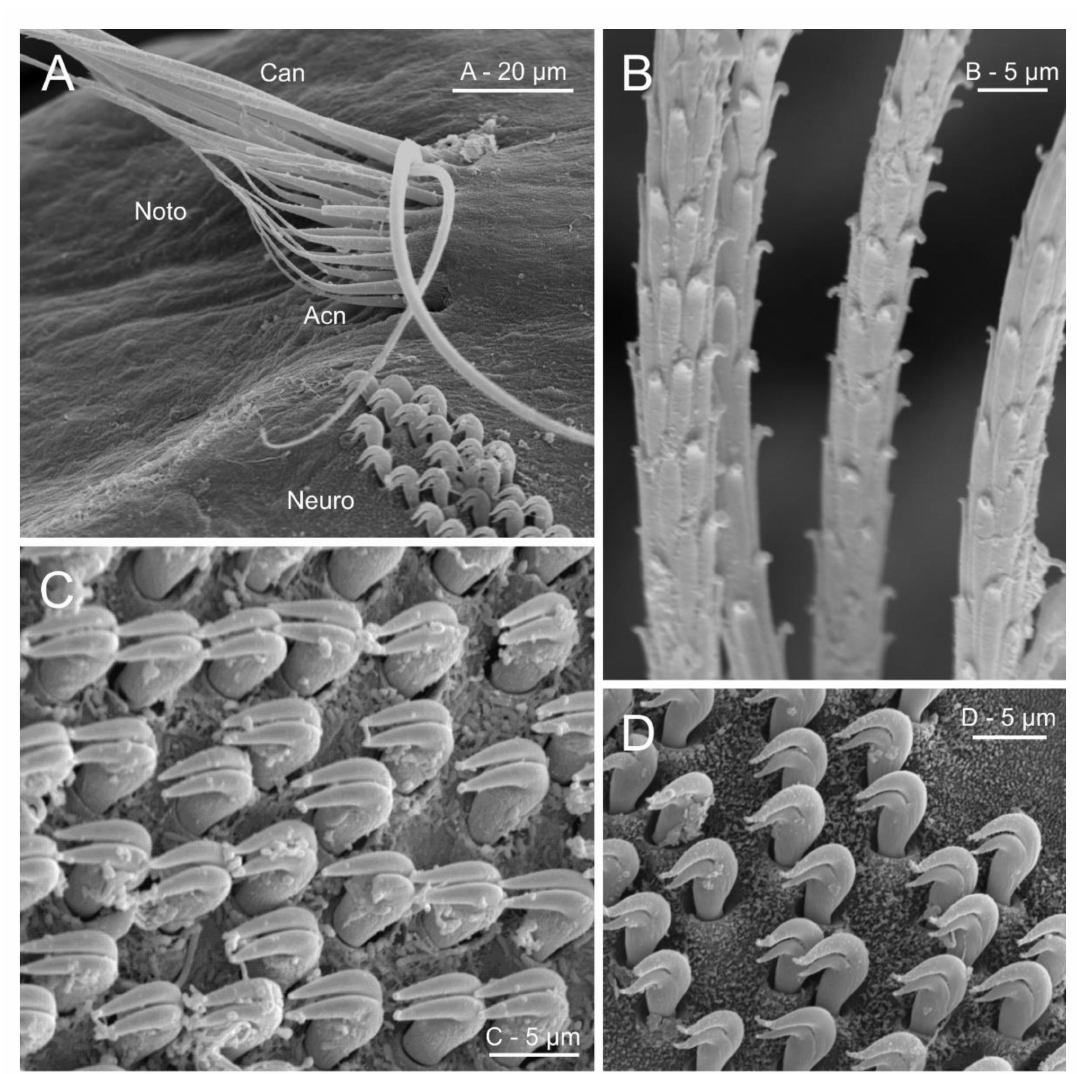
Figure 16. SEM micrographs illustrating several chaetal characters in Oweniidae. ( A ) Anterior abdominal chaetiger in Myriochele olgae ; ( B ) detail of thoracic notochaetae scale covering of Owenia fusiformis ; ( C ) neuropodial uncini of O. fusiformis ; ( D ) neuropodial uncini of M. olgae . Abbreviations: Acn—acicular notochaetae, Can—capillary notochaetae, Neuro— neuropodium,